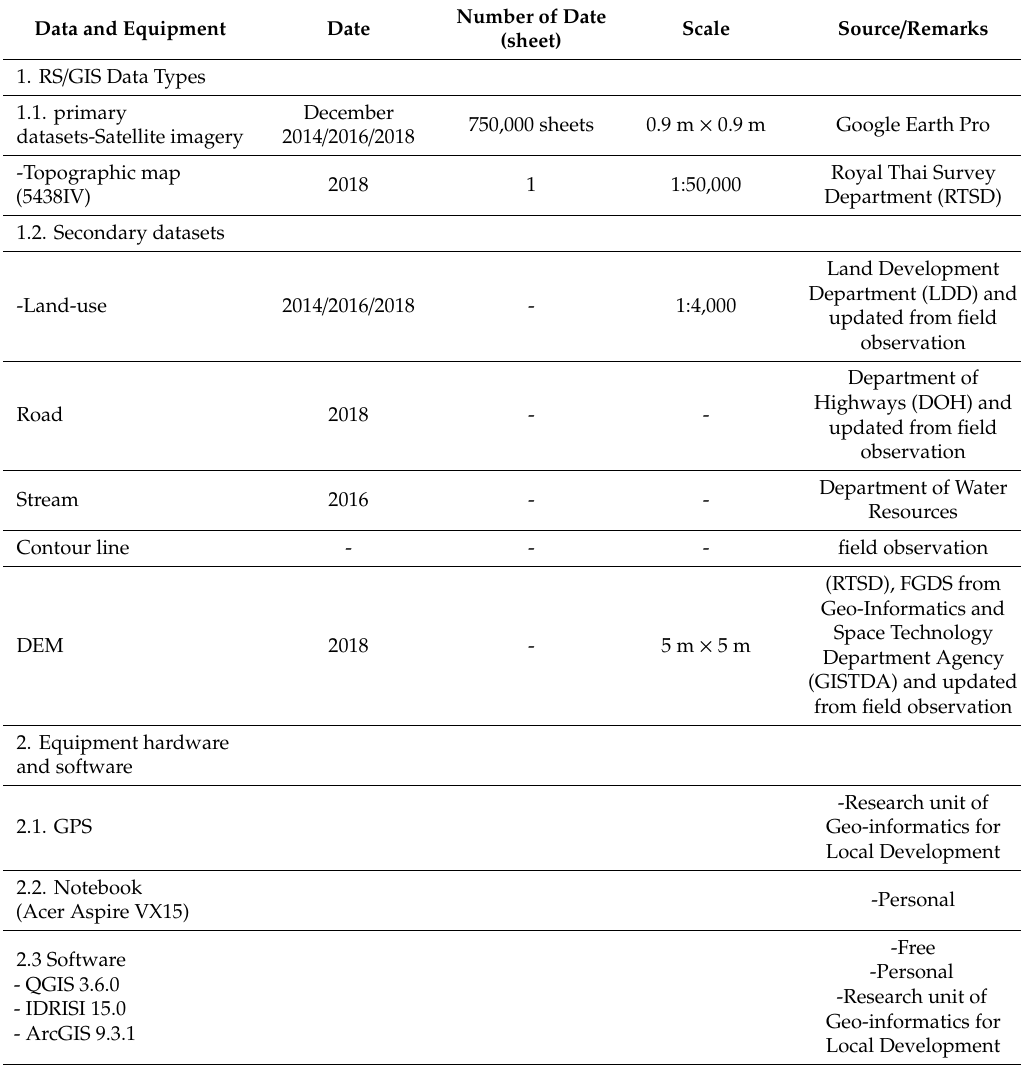
Table A11. Data and Equipment.